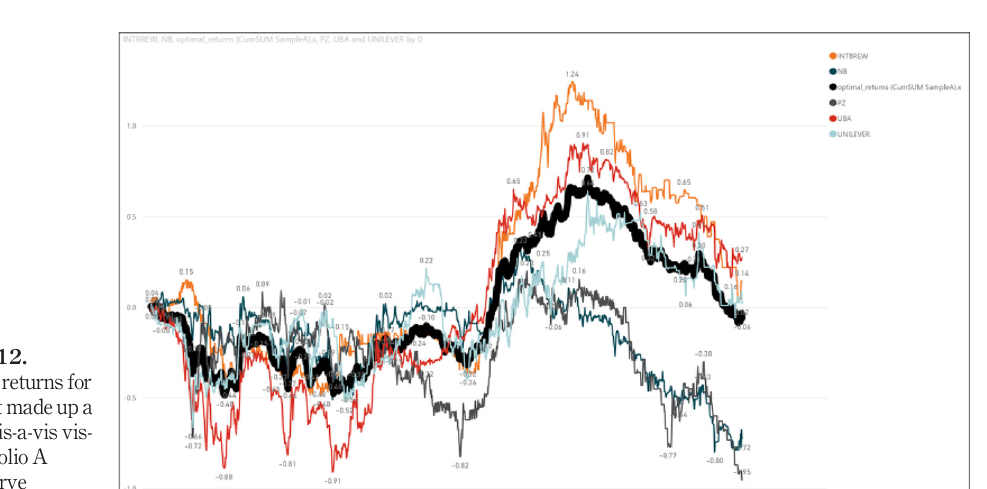
Figure A12. Individual returns for stocks that made up a portfolio vis-a-vis vis- à-vis Portfolio A optimal curve